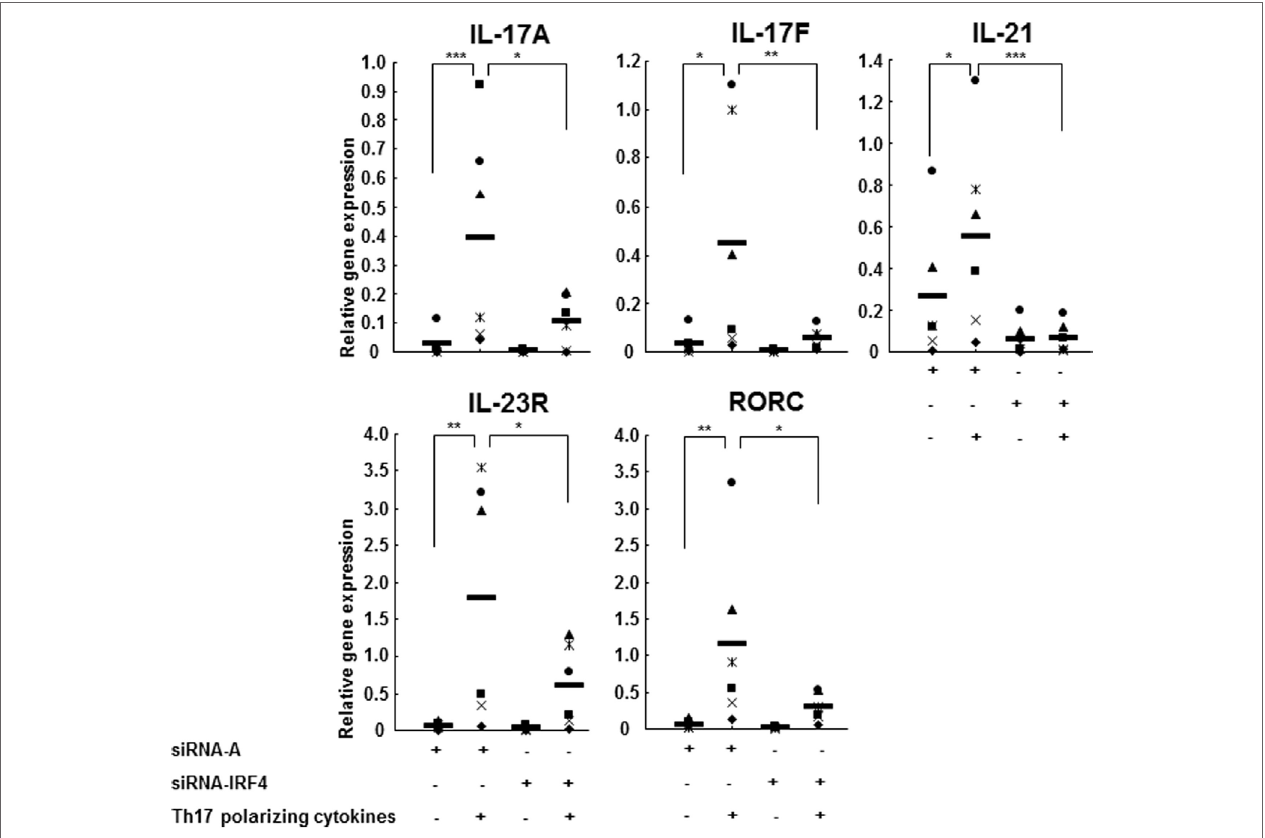
FigUre 6 | il-1r1 positively regulates human Th17 cell differentiation in an irF4-dependent manner . CD4 + CD45RA + cells from six RR MS patients transfected with a control siRNA A or siRNA IRF4 were stimulated with plate-immobilized anti-CD3 and anti-CD28 mAb and cultured in serum-free medium in the absence or presence of Th17-polarizing cytokines. After 72 h, the total RNA was extracted. The gene expression was measured by RT-PCR. The results are expressed as relative gene expression normalized for 18S mRNA expression. Statistical analysis was performed using ANOVA. * p < 0.05, ** p < 0.01, *** p <